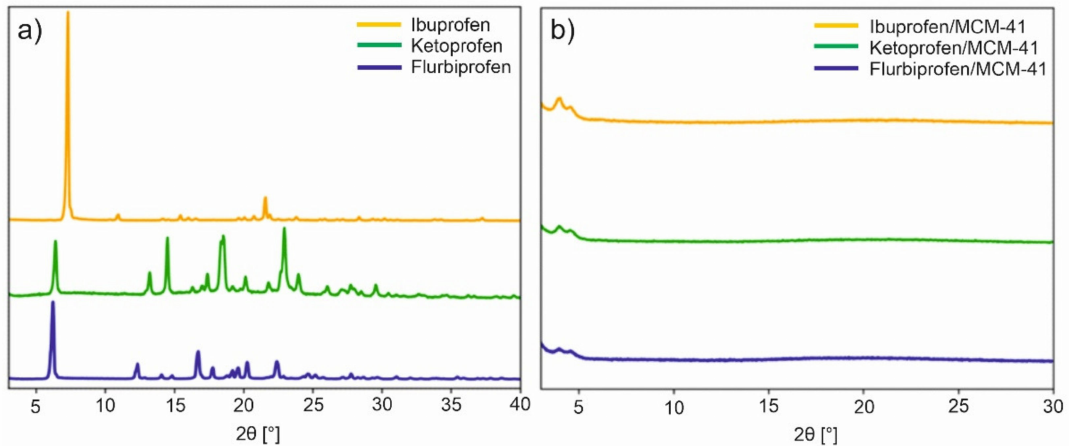
Figure 16. PXRD diffractograms of ( a ) untreated ibuprofen, ketoprofen, and flurbiprofen, and ( b ) 1:3 drug-loaded MCM-41. Adapted with permission from [47], Copyright 2020